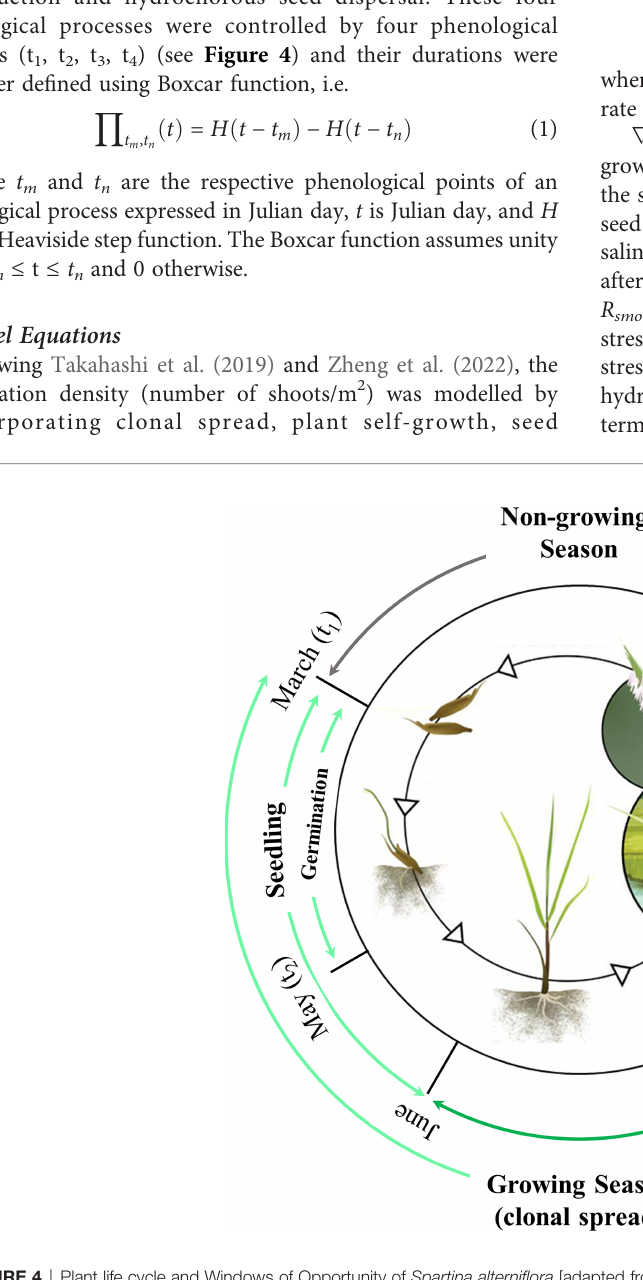
FIGURE 4 | Plant life cycle and Windows of Opportunity of Spartina alterni fl ora [adapted from Vanderklift et al.